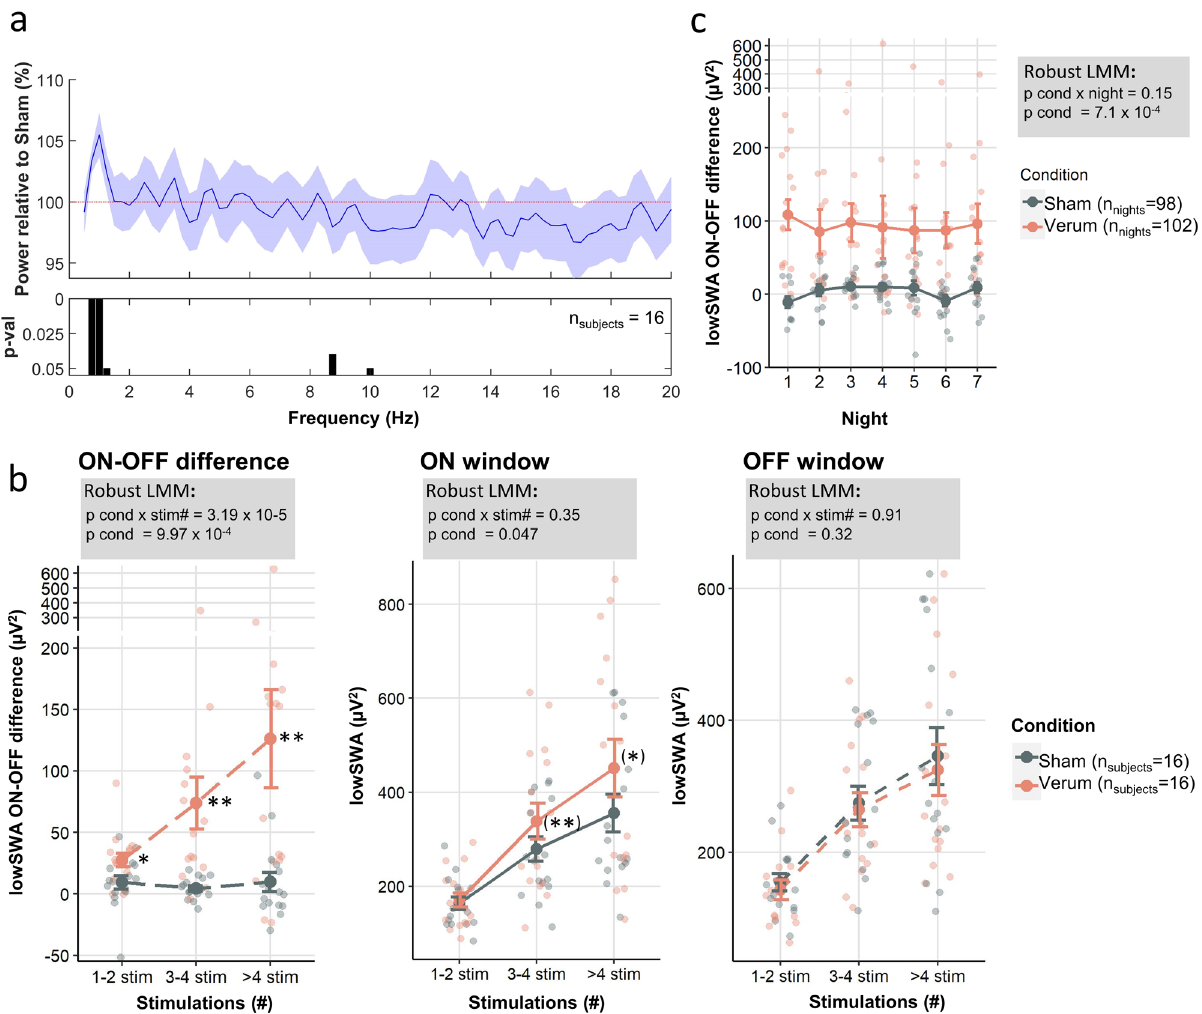
Fig. 2 Slow wave effect of auditory stimulation in the windowed stimulation approach. a Ratio (mean, shaded area SEM) between Verum and Sham in the windowed approach of the normalized spectral density (power divided by cumulative electroencephalography [EEG] power up to 30 Hz) during non- rapid eye movement (NREM) sleep (device and of fl ine detected, consecutive analysis see methods) shows a signi fi cant cluster of frequency bins in the low-frequency range of 0.75 – 1.25 Hz (lowSWA). P -values ( fi xed factor condition, cond) were derived from a robust linear mixed model (see methods) performed for each frequency bin separately. b Error bars (mean ± SEM) with data points representing individual participants of ON-OFF window analysis of lowSWA for the difference between ON-OFF, ON windows, and OFF windows (see methods). Windows with stimulations (triggers or tones) were sorted and matched for their number of stimulations (stim#, 1 – 2 stimulations (1 – 2 stim), 3 – 4 stimulations (3 – 4 stim), and more than 4 stimulations (>4 stim)) and compared between Verum and Sham condition. Overall robust linear mixed model results (model includes average of nights) are summarized in the gray panels. The y-axis has been condensed to better visualize the error bars despite outliers. In case of signi fi cant main or interaction effects, a robust linear mixed-effects model was calculated for each stimulation bin separately (robust linear mixed-effect model [LMM], model includes all nights, *indicate p < 0.05 **indicate p < 0.01, stars in brackets illustrate exploratory analysis because of non-signi fi cant interaction effect). Effect of ON-OFF difference is driven by a signi fi cant increase of lowSWA in the ON window as indicated by a signi fi cant main effect of condition in a robustLMM, but not the OFF window. Following this signi fi cant overall model, separate robust LMM including all nights depict that speci fi cally stimulation bins with more than 2 stimulations (3 – 4 stim, >4stim) show a signi fi cant condition effect in the ON window (*indicate p < 0.05). c In an additional analysis of all the ON-OFF window differences with more than 2 stims, we focused on whether there is a consistent difference between Verum and Sham for all seven nights. Results are shown as error bars (mean ± SEM) and data points represent individual nights of 16 participants. The y -axis has been condensed to better visualize the error bars despite outliers. In a robust LMM with factors nights, conditions, and control fi xed and random factors (see methods) revealed no signi fi cant interaction night x condition ( p > 0.1) and a main effect condition ( p < 0.001), indicating a signi fi cant effect between Sham and Verum across all seven nights. Solid lines refer to ON window results, long dashed lines to ON-OFF difference and short dashed lines to OFF window results. Data underlying this fi gure is provided in Supplementary Data